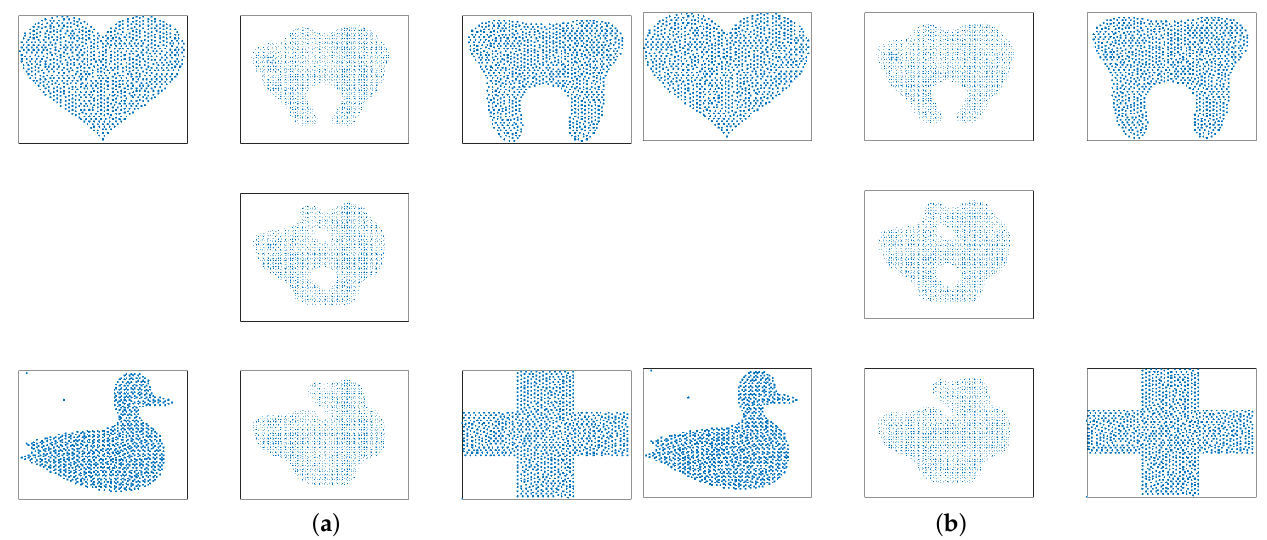
Figure 7. Given measures: { 1,4,6,7 } , entropy regularization parameter η = 5 · 10 − 3 , r = 150, ( 1,1,1,1 ) . NFFT-Sinkhorn parameters: M = 156, p = 3. The test images are adapted with ˜ w = 1 4 permission (MIT License) from https://github.com/PythonOT/POT, see [54]. 2016, Rémi Flamary. ( a ) Sinkhorn. ( b )